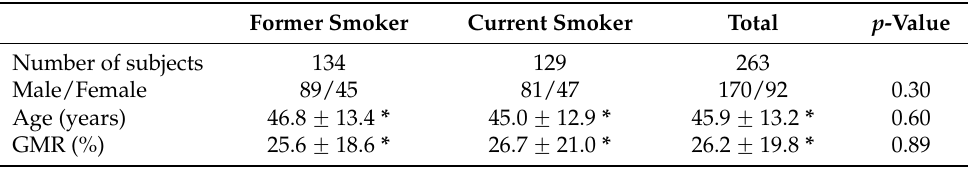
Table 1. Patient demographics at baseline. Table 1 . Patient demographics at baseline.